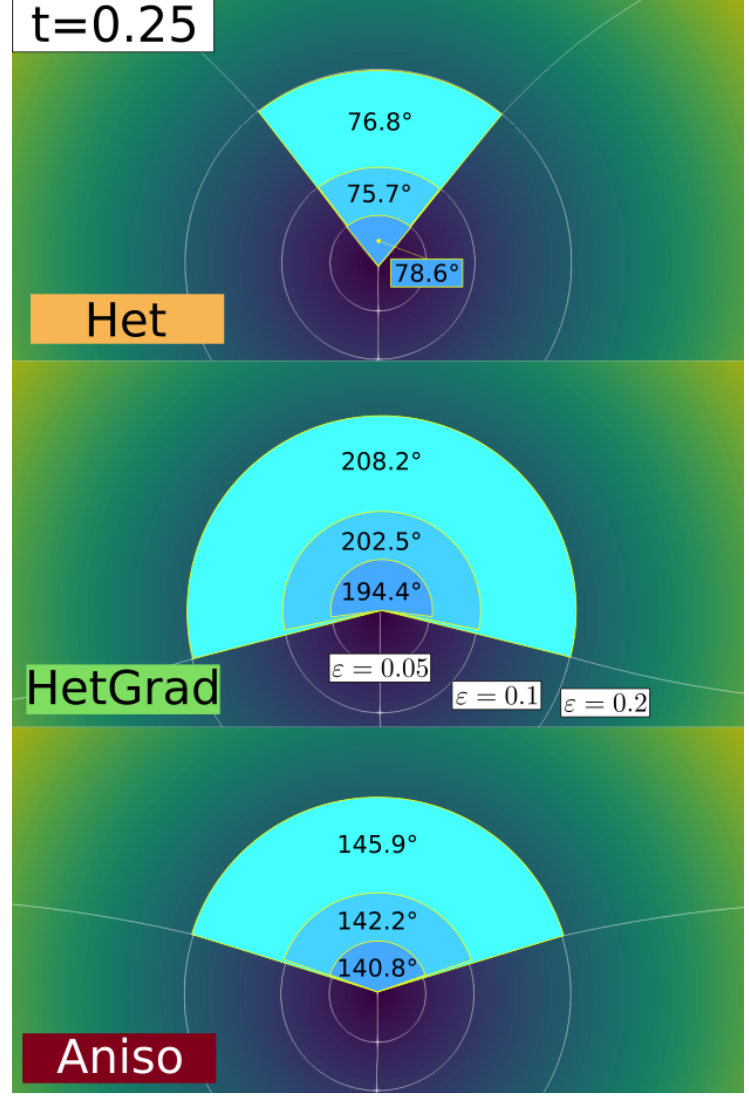
10 − 4 , ∆ t = 1 10 − 5 . The three white × × 0.05,0.1,0.2 used to compute the top dihedral angle. One can { }